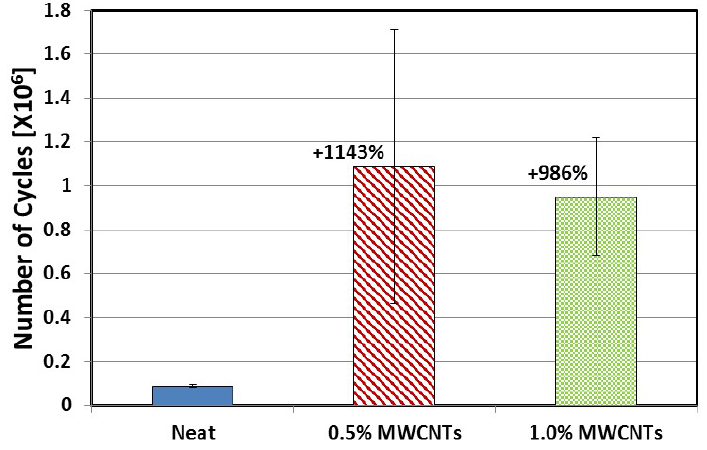
Figure 6. Number of cycles in million until failure for the neat, 0.5% MWCNTs, and 1.0% MWCNTs. % presented represents the improvement of the number of cycles to failure of GFRP composites compared to reference